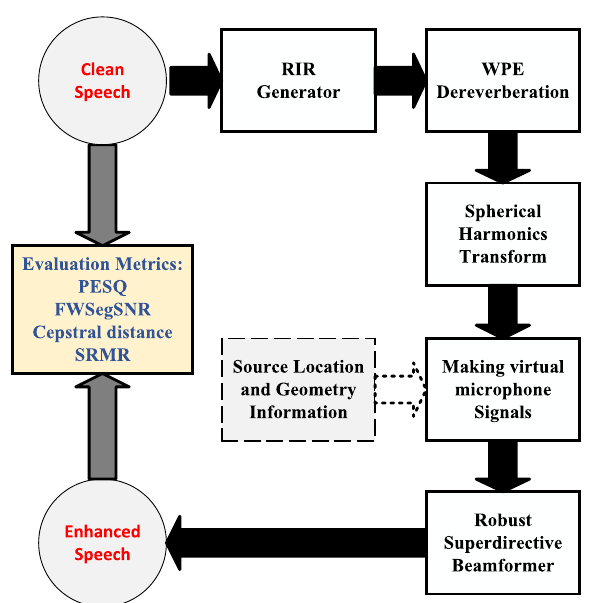
Fig. 4 Block diagram of the experimental